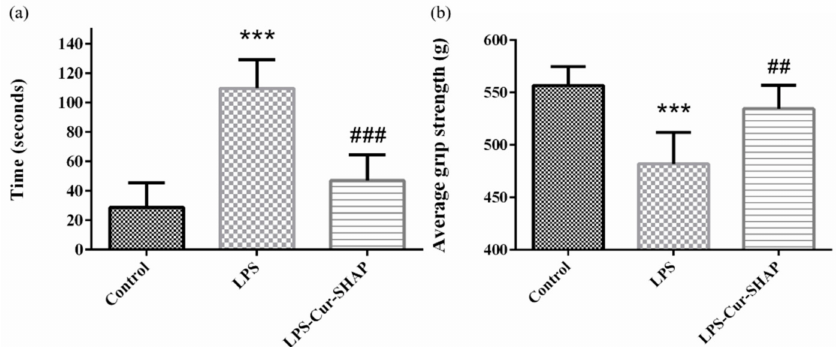
Figure 9. Muscle endurance and grip strength measurement. ( a ) Muscle endurance analysis using the treadmill test. ( b ) Average grip strength was measured using a grip strength meter ( n = 6, *** p < 0.001 compared to the control group; ## p < 0.01, ### p < 0.001 compared to the LPS group). According to these results, muscle endurance and grip strength may be completely restored in rats with LPS-induced sarcopenia that have been treated with Cur-SHAP for 2